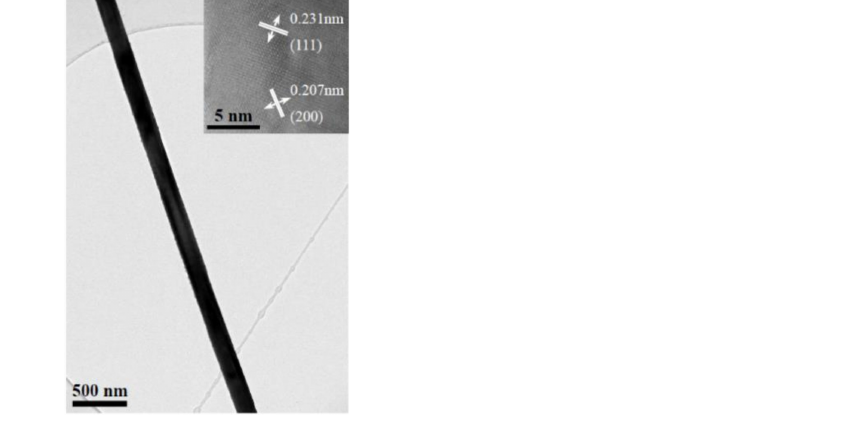
Figure 5. TEM images of Ag NWs/C and corresponding HRTEM images